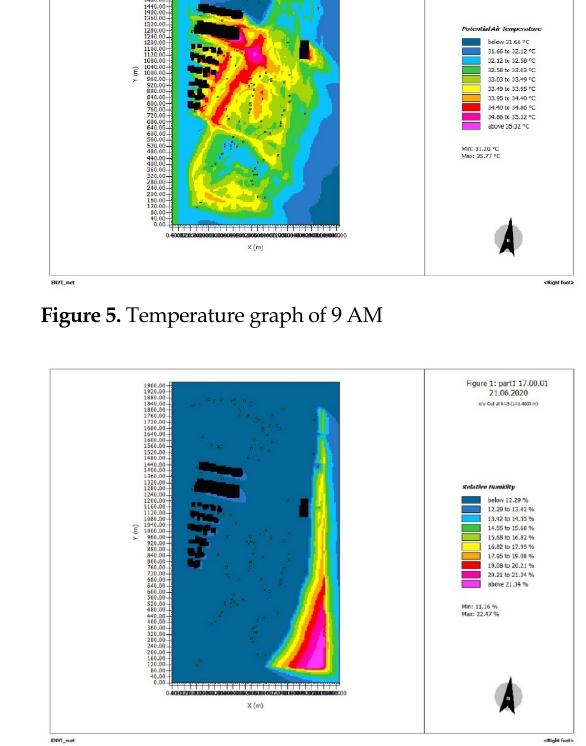
Figure 7. Humidity at 9 AM Figure 8. Humidity at 5 PM